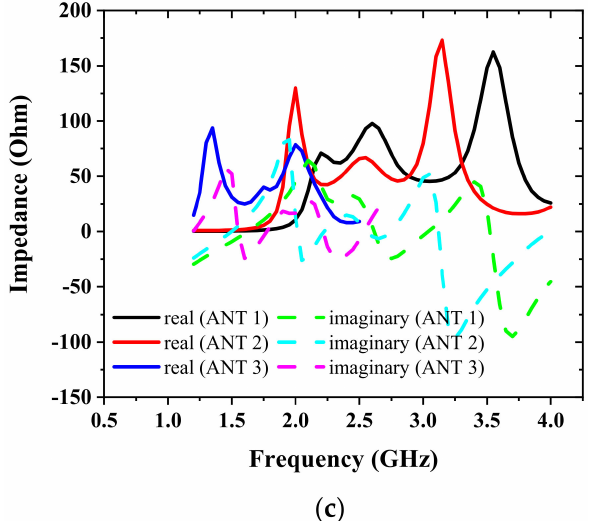
Figure 5. ( a ) The structure of ANT 1, ANT 2, and ANT3; ( b ) VSWR of ANT 1, ANT 2, and ANT3; ( c ) impedance of ANT 1, ANT 2, and ANT